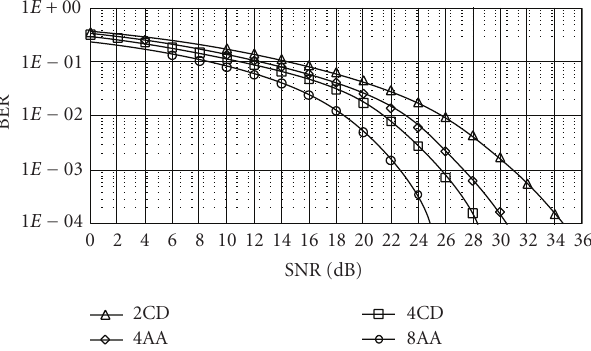
Figure 11: BER versus SNR with Doppler shift of 0Hz.